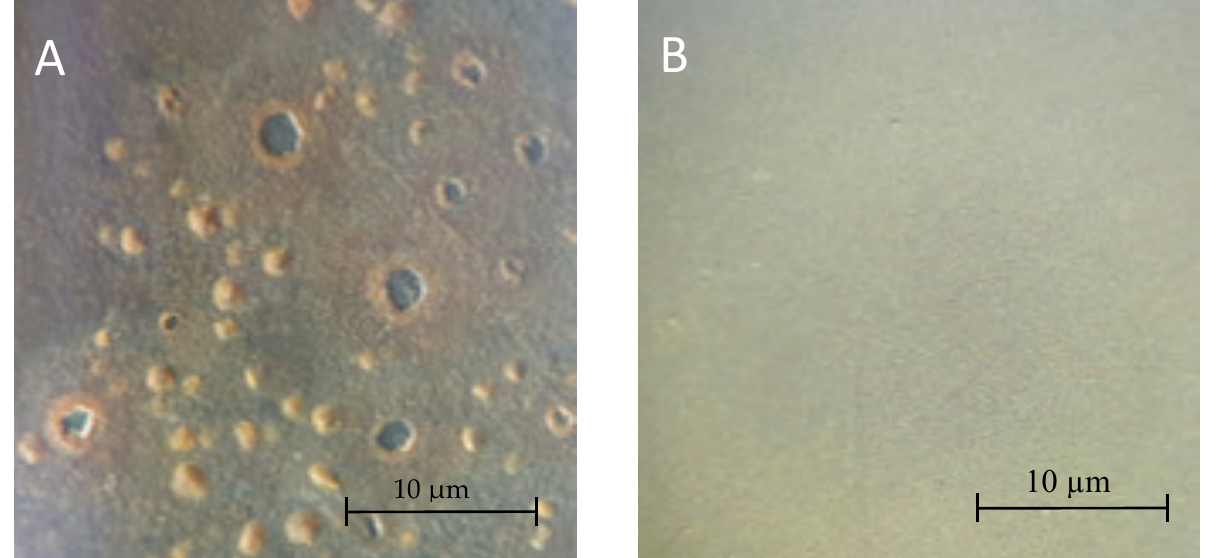
Figure 9. Photographs of A284 steel sample surfaces after a 200-h exposure in 25 wt.% NaCl aqueous solution: ( A ) uncoated sample, ( B ) sample with boron coating.